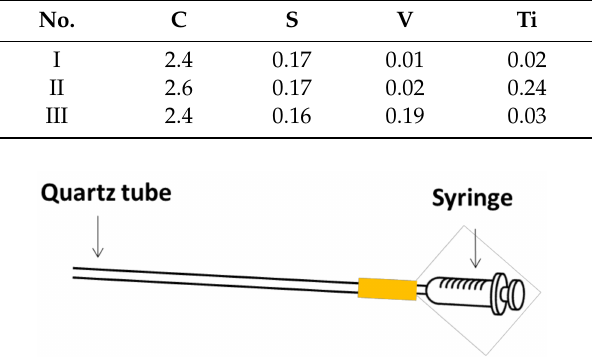
Figure 3. Diagram of sampling